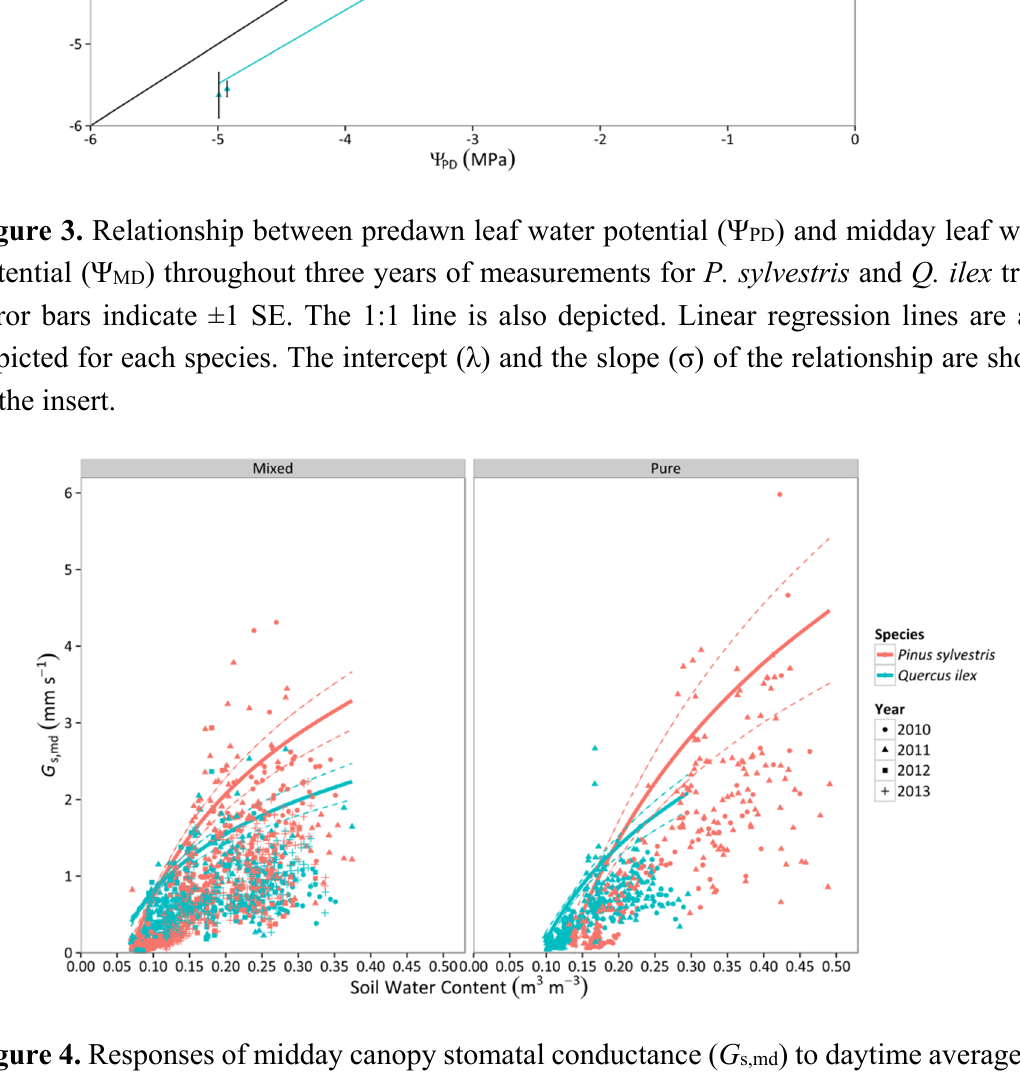
Figure 4. Responses of midday canopy stomatal conductance ( G s,md ) to daytime averages of SWC in two different stand types throughout four consecutive years. Average values for P. sylvestris and Q. ilex trees are shown. Standard errors of individual measurements are not displayed to improve clarity. Solid lines represent the quantile regression fit of the 95th percentile and dashed lines are the 95% confidence intervals of the quantile